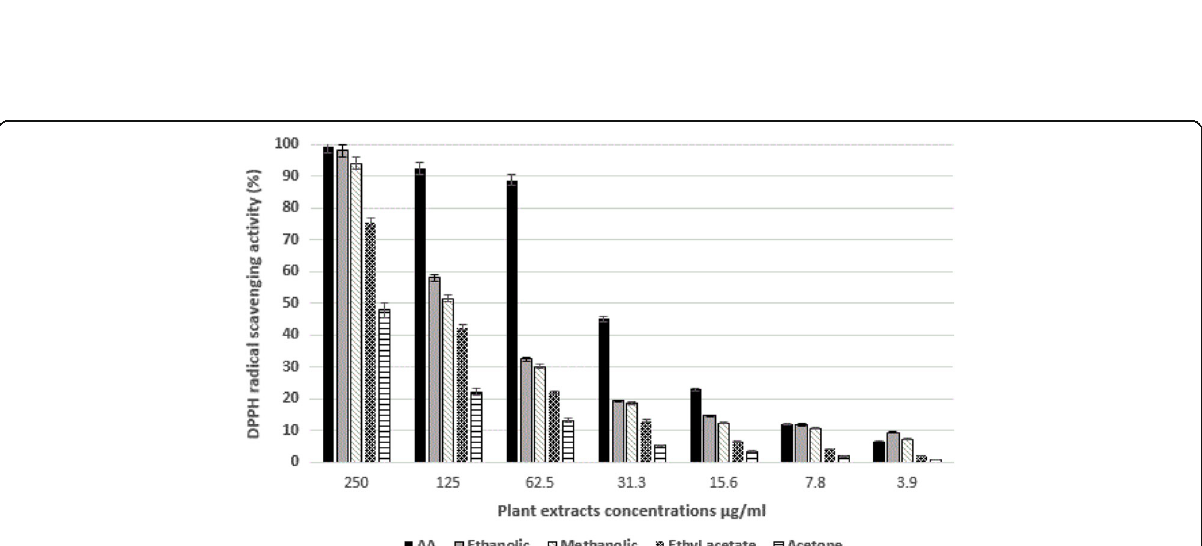
Fig. 2 2,2-Diphenyl-1-picrylhydrazyl (DPPH) radical scavenging activity of different concentrations of different extracts of C. azarolus var. eu- azarolus . Ascorbic acid (AA) was used as positive control. The data presented as mean ±